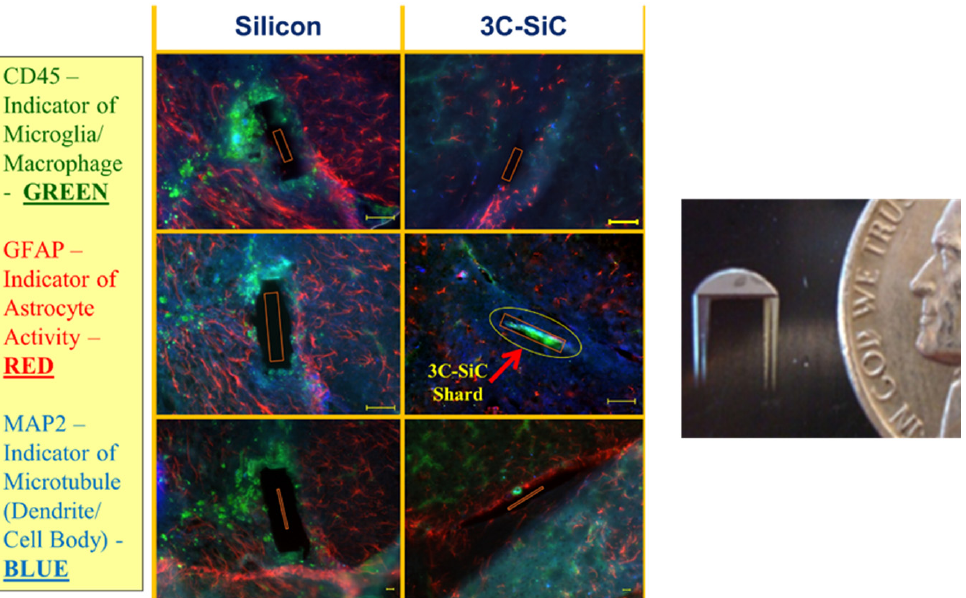
Figure 4. Microscope which was used for the immunofluorescence analysis of C57BL/6J mouse hippocampal tissue. Each row represents a selected tissue slice from a single animal (N = 3). The first column shows the tissue response within the left hemisphere of the hippocampus surrounding the Si implant and the second column presents the tissue associated with 3C-SiC within the right hemisphere. The legend on the left details the antibody stains used in the study. The orange boxes denote the approximate size of the implant at the tissue location. The scale bars are all 50 µ m in length. Image from [3]. Right photograph of implanted passive probes showing Si ( left ) and 3C-SiC ( right ) double-shanks glued together for simultaneous implantation into wild-type mice. Red rectangles marking the implant dimension have been superimposed for reference, which show significant neural tissue loss extending beyond the Si implants while no tissue loss was observed for 3C-SiC